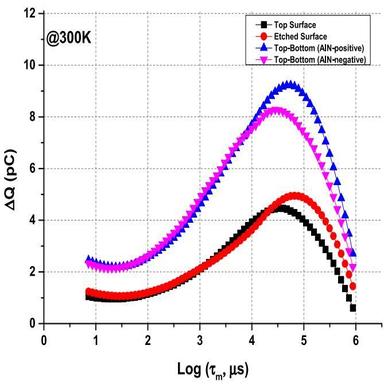
Q-DLTS analysis of AlN–Si stack.